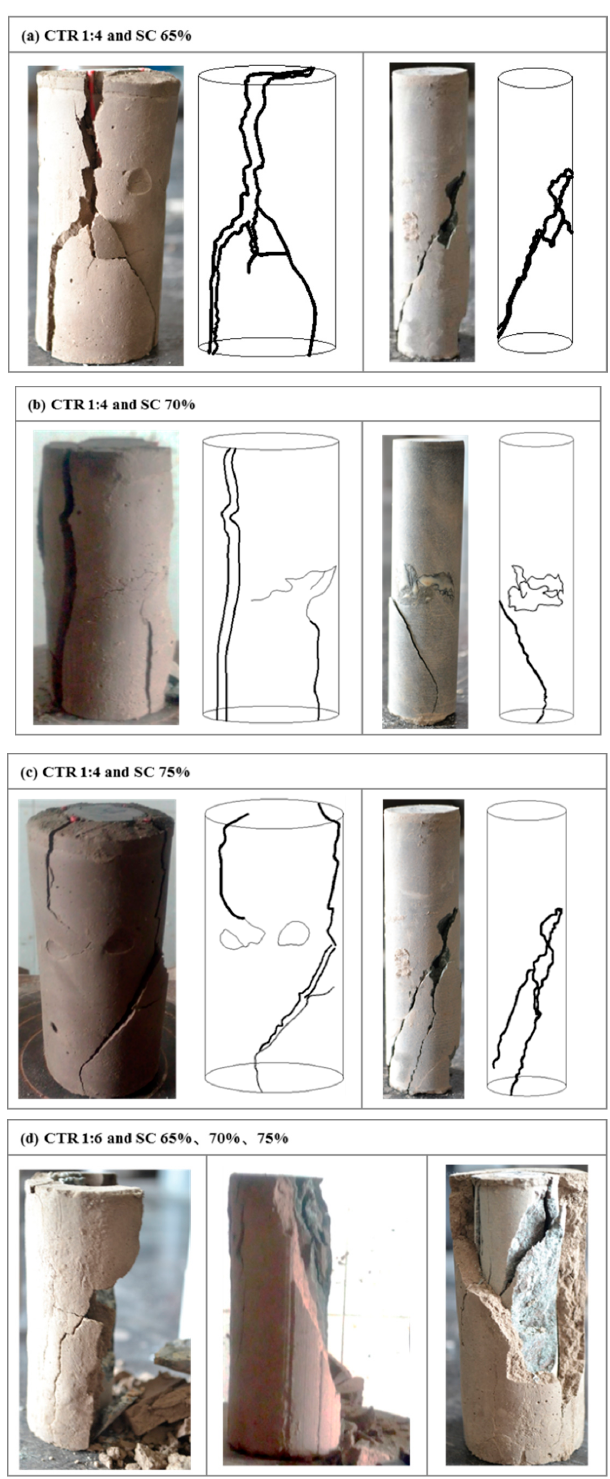
Figure 10. Failure mode of the CTB-RC specimens with CTR 1:4 and SC 75%. The sketches in ( a ), ( b ), and ( c ) were drawn manually in Auto CAD according to the real cracks. Specimens in ( d ) with the CTR 1:6 and different SCs were completely peel off because of its serious damage.